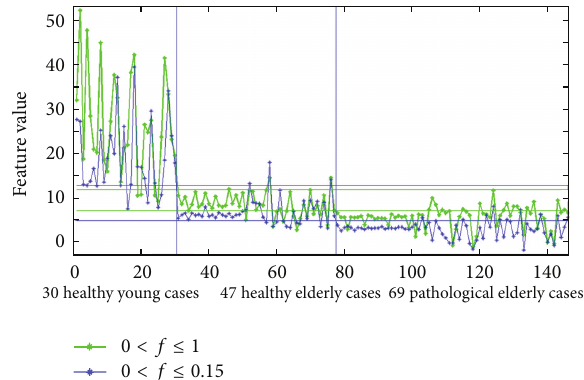
Figure 19: Differentiation between healthy young cases, healthy elderly cases, and pathological elderly cases (suffering from CAD), when using the two spectral area measures for normalized frequencies 0 < 𝑓 ≤ 1 (green curve) and 0 < 𝑓 ≤ 0.15 (blue curve) as proposed in